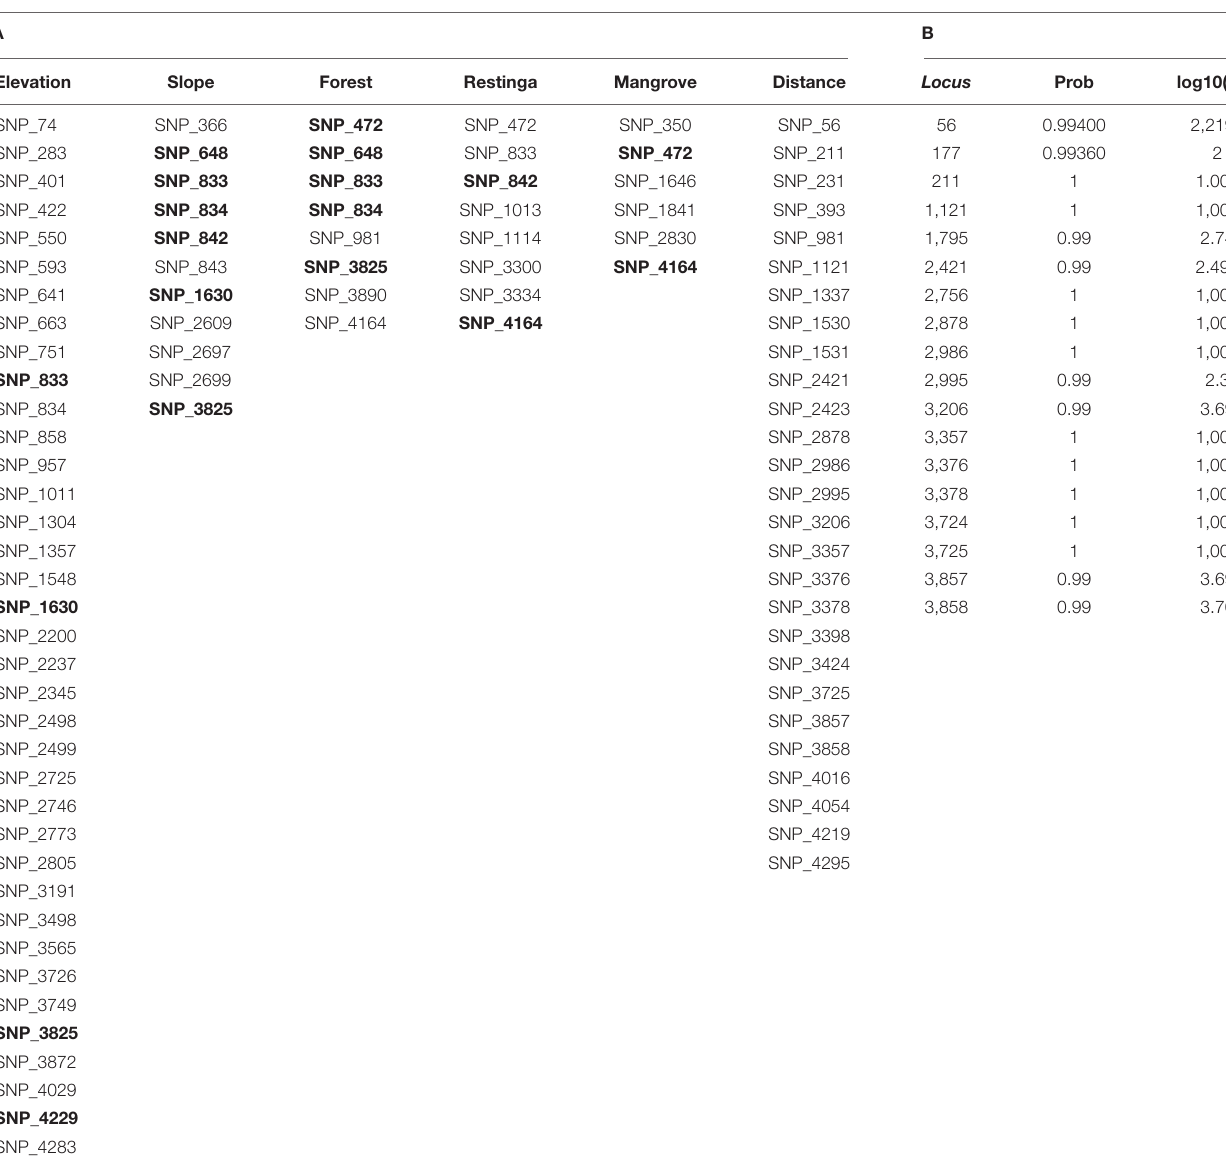
TABLE 4 | Putative loci under adaptive